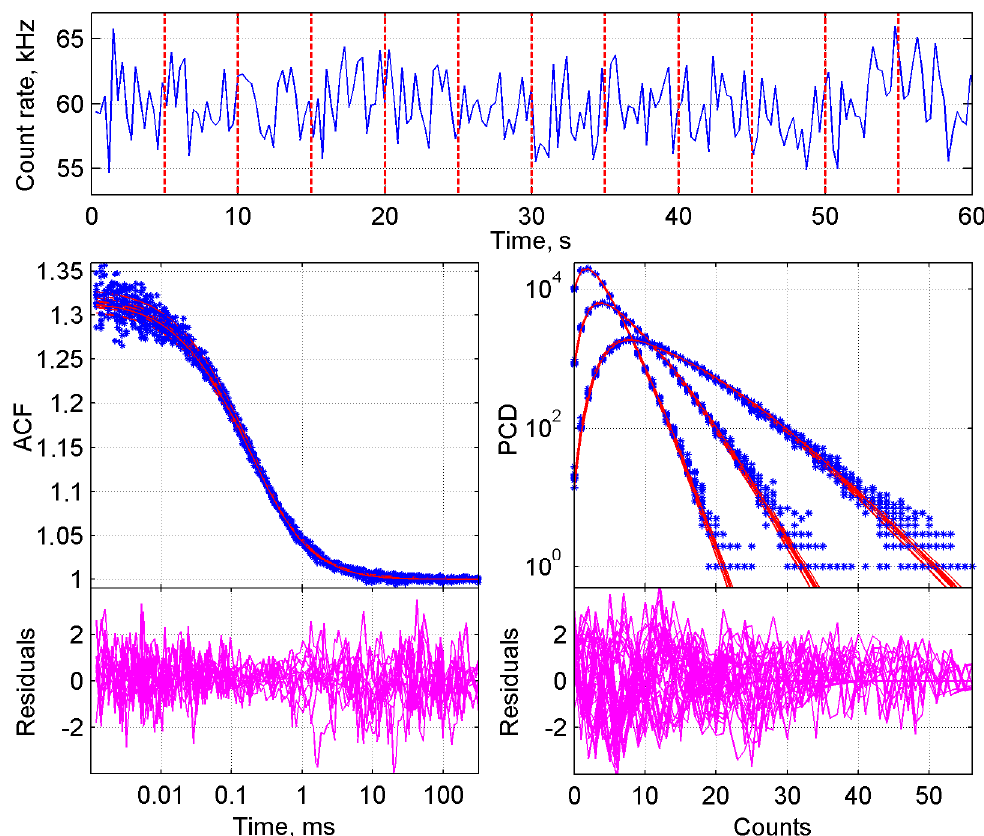
Figure 1. BDGA analysis of the ACF and PCD curves from a monomer-dimer ‘equilibrium’ in cell lysate. The sample consisted of 50% GFP and 50% diGFP, mimicking a stable equilibrium between two species. Top panel: raw FFS data showing photon counts over time, from which the ACF and PCD curves were calculated. The measurement was divided into twelve 5-s traces, as indicated by vertical lines. Bottom left: 1-component fit of all ACF curves, with residuals below. Bottom right: 1-component fit of all PCD curves, with residuals below. PCD curves were generated with three different time steps of 5 × 10 − 5 , 1 × 10 − 4 and 2 × 10 − 4 s, respectively.